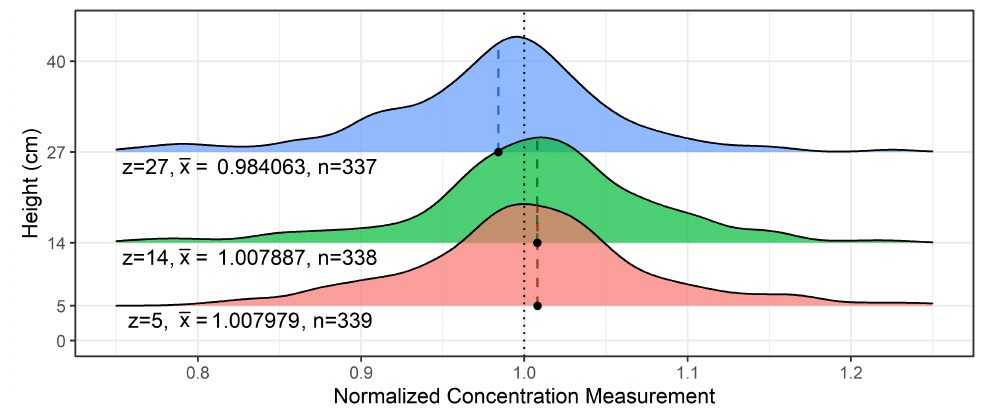
Figure A3. A ridgeline plot of suspended sediment concentration measurements. At each height where we measured concentration (5, 14, and 27 cm above the bed), a smoothed histogram of normalized concentration measurements at that height is inset. Points and dashed vertical lines indicate mean values ( ¯ x ), which are also annotated along with sample size.